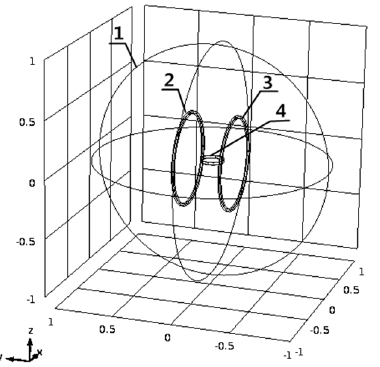
Figure 1. Structural illustration of magnetic nanoparticle detection platform.